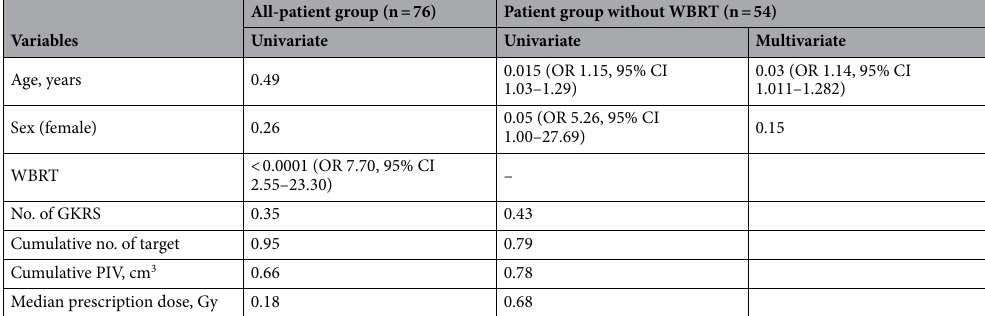
Table 6. Factors associated with development of radiation-induced leukoencephalopathy based on univariate and multivariate analyses. GKRS gamma knife radiosurgery, PIV prescription isodose volume, WBRT whole brain radiotherapy, OR Odds ratio, CI confidence